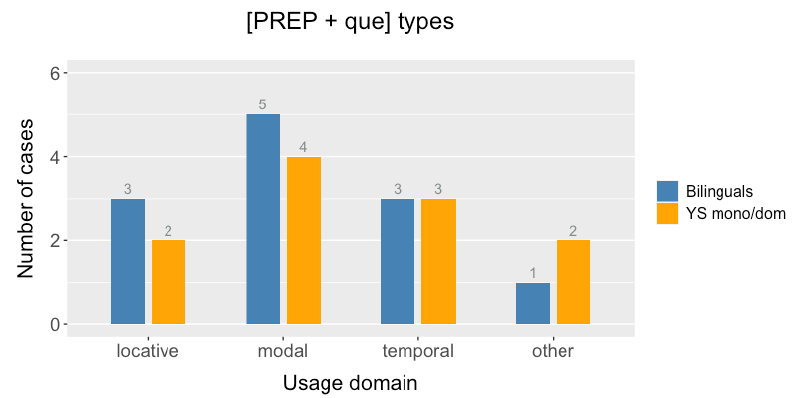
Figure 7. Results for determiner-less complementizers in the relative clause data.